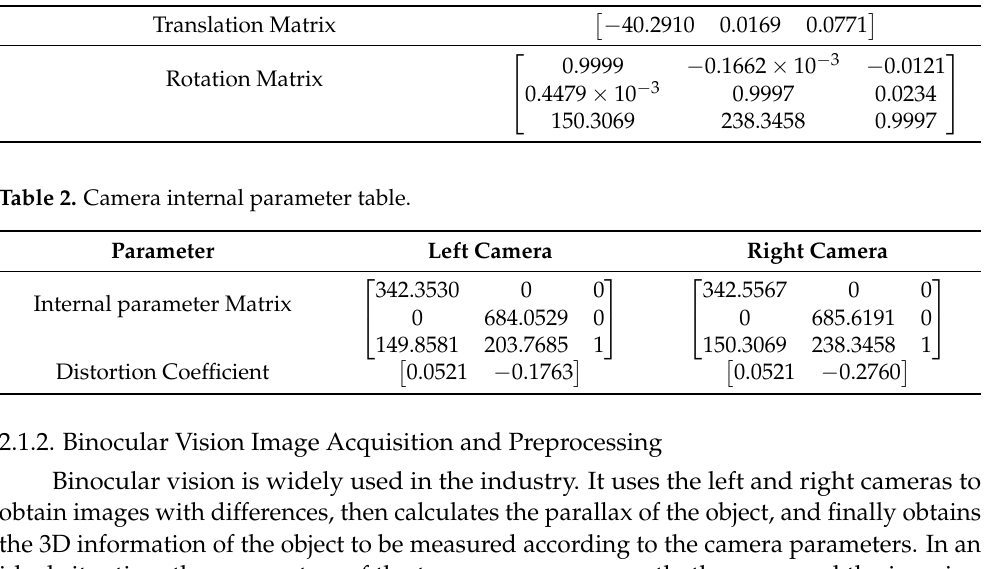
Figure 2. Partially calibrated pictures of the camera. Table 1. Camera external parameter table.